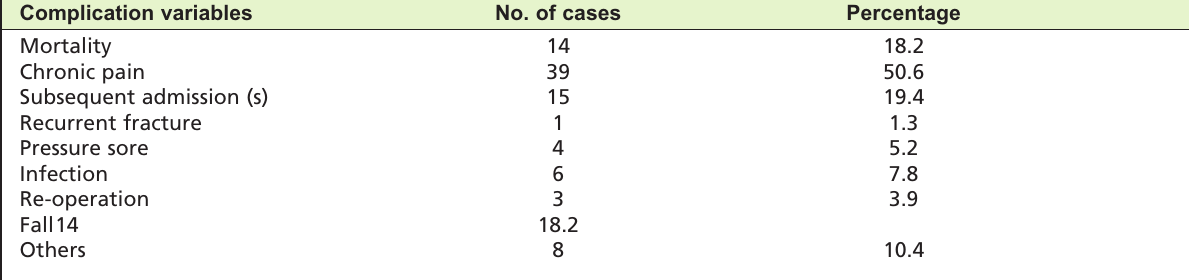
Summary of reported complications after a hip Table III: